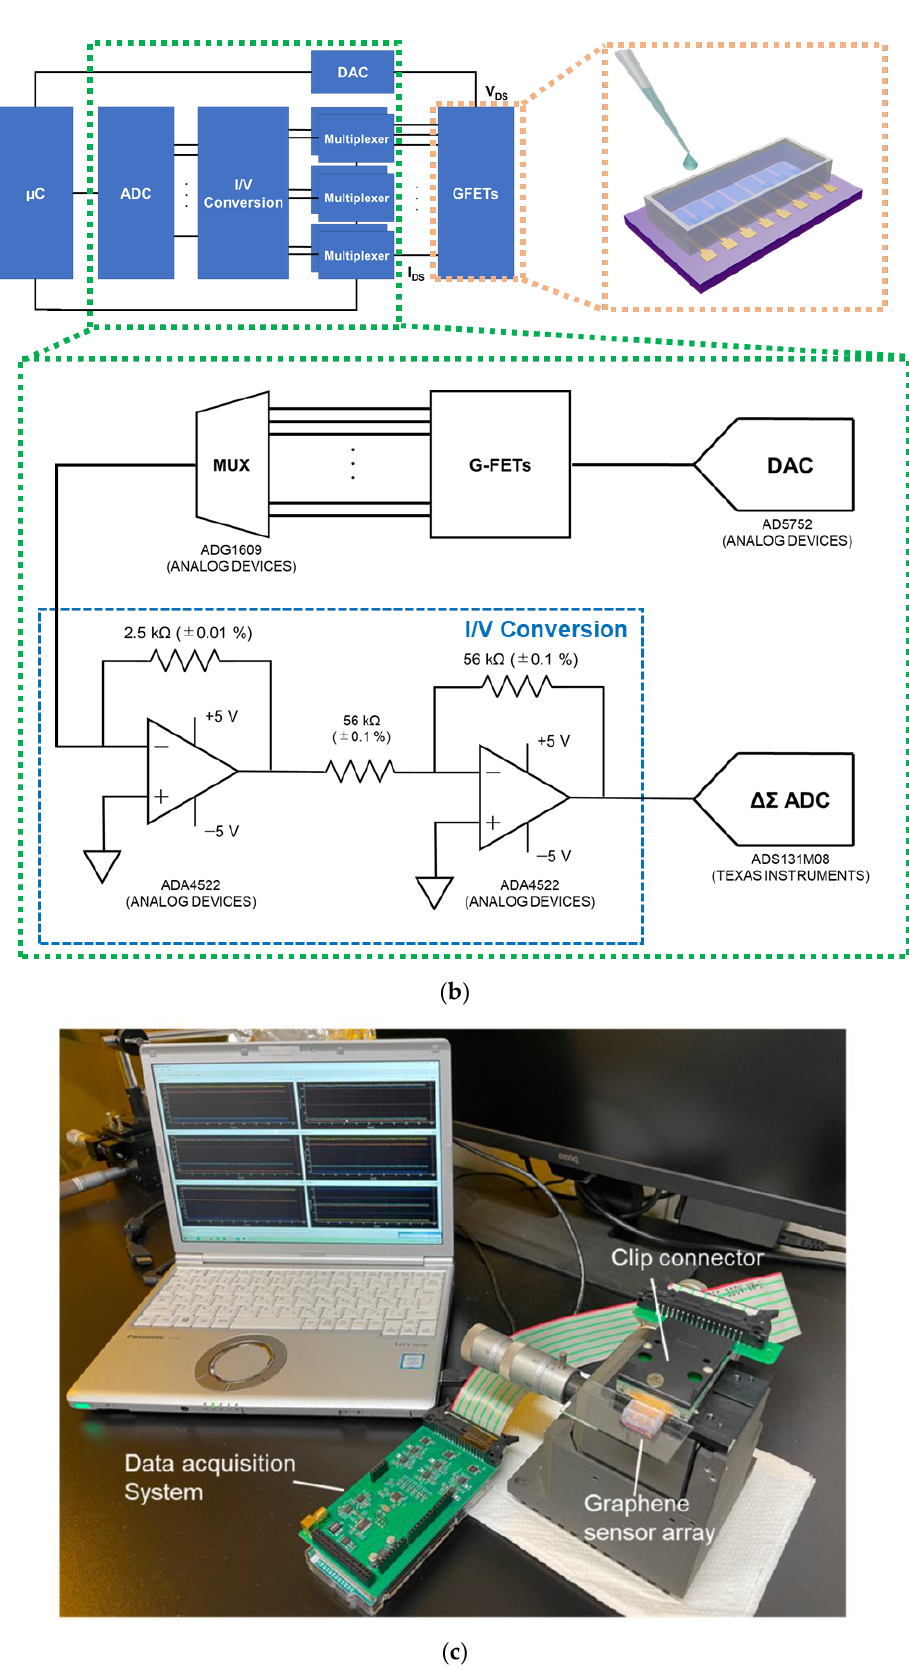
Figure 1. Schematics of ( a ) the fabrication process of the graphene-sensor array, ( b ) the hand-held measurement system, and ( c ) the measurement